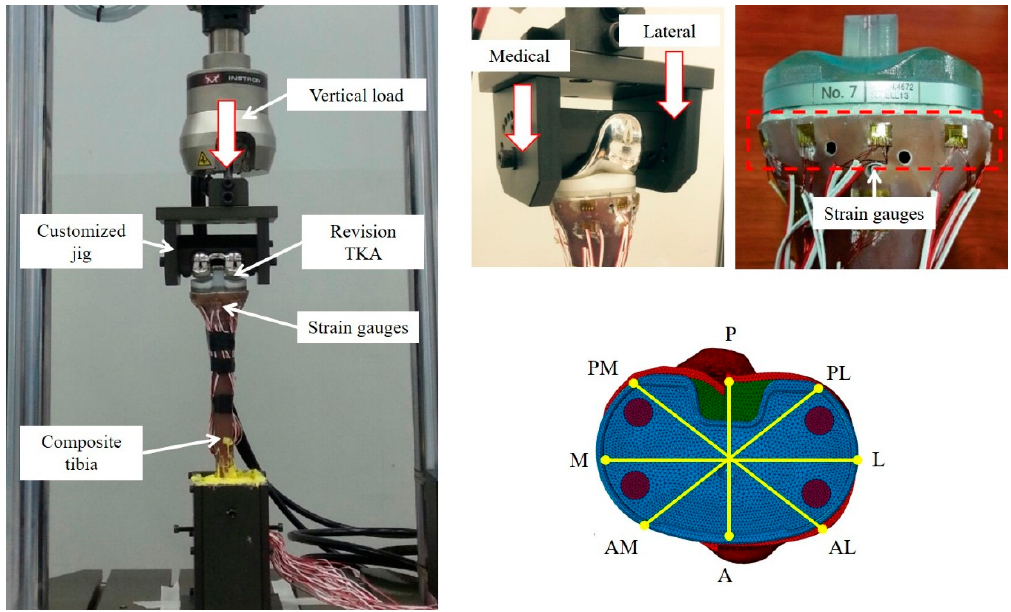
Figure 3. Mechanical test configuration for FE model validation. (A, anterior; M, medial; L, lateral; P, posterior; AM, anterior-medial; AL, anterior-lateral; PM, posterior-medial; PL, posterior-lateral region).